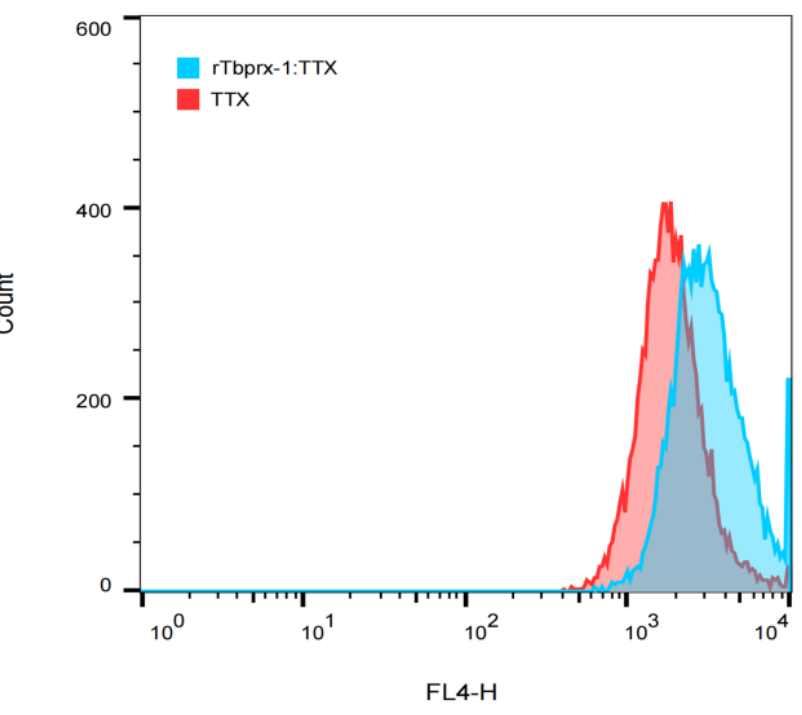
Figure 8. Binding activity of rTbprx-1 with tetrodotoxin (TTX). Steady—state fitting to obtain the KD value of rTbprx-1.